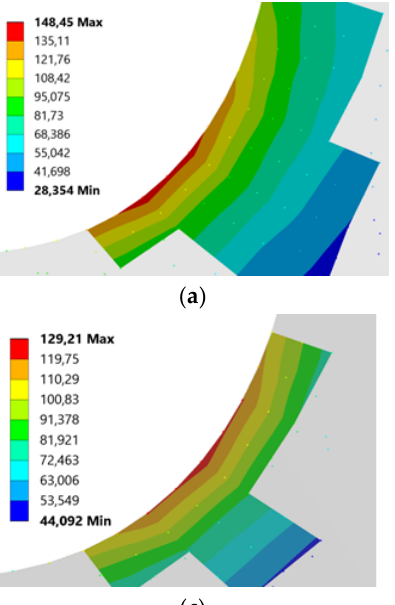
Figure 16. Shear stress results for hybrid gears generated rack tip radius, ρ 1 = 0.3 xm for different RTs; ( a ) 0.5 xm, ( b ) 1 xm, ( c ) 1.5 xm, ( d ) 2 xm.